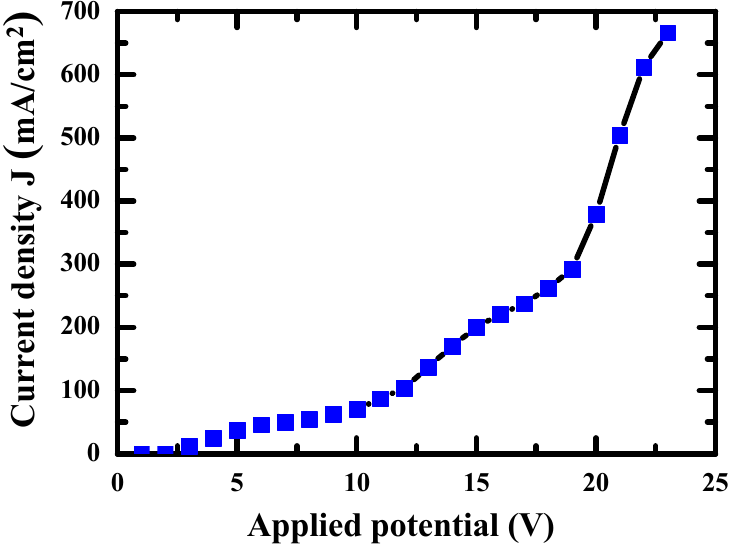
Figure 4. The anodic current density versus applied potential (V) plot for the EP processing.